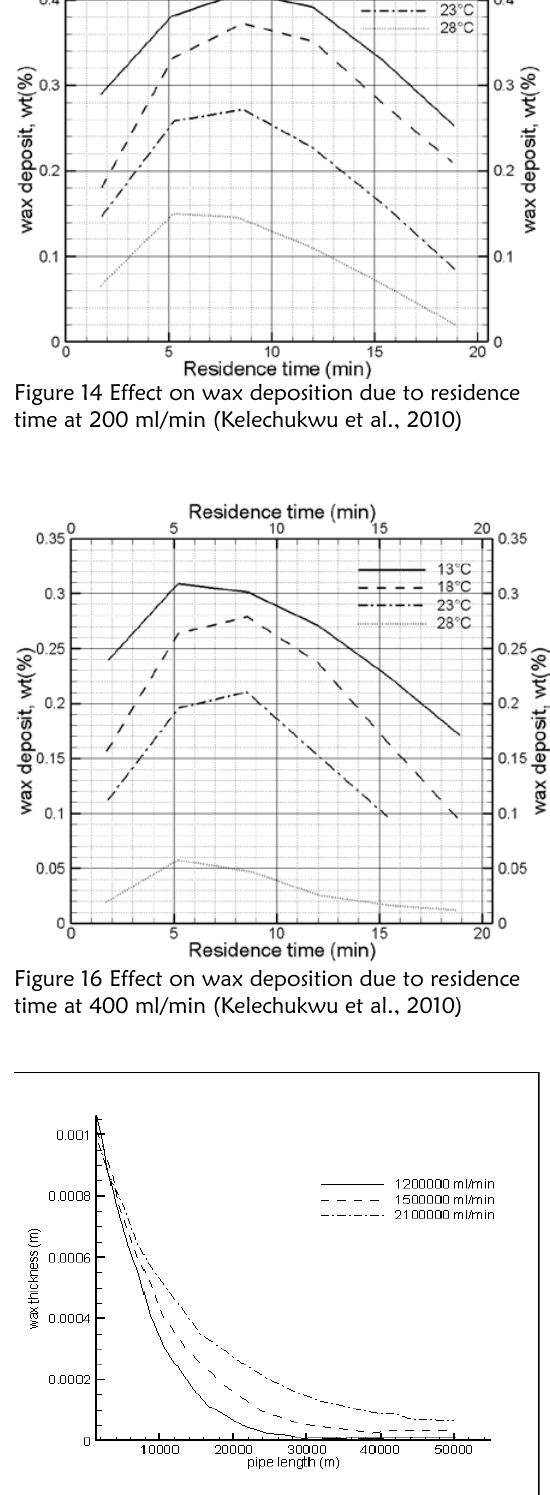
Figure 18 Effect of pipe length on wax thickness (Gooya et al.,